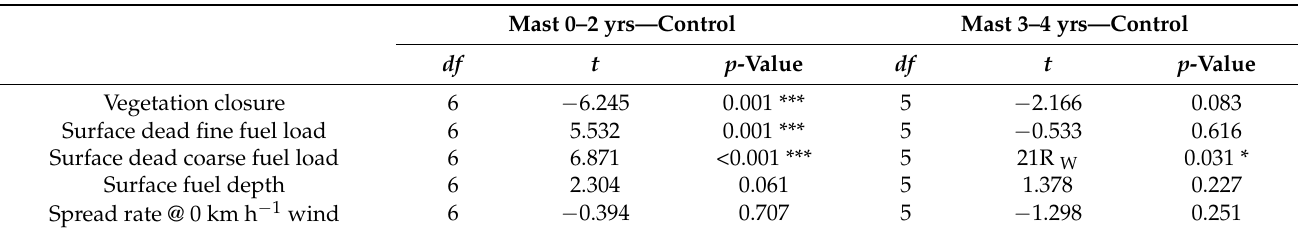
Table A2. Results of paired t -test or nonparametric Wilcoxon signed-rank test. Includes degrees of freedom ( df ), test statistic ( t ) and p -value. Statistical significance denoted by * p ≤ 0.05; ** p ≤ 0.01; *** p ≤